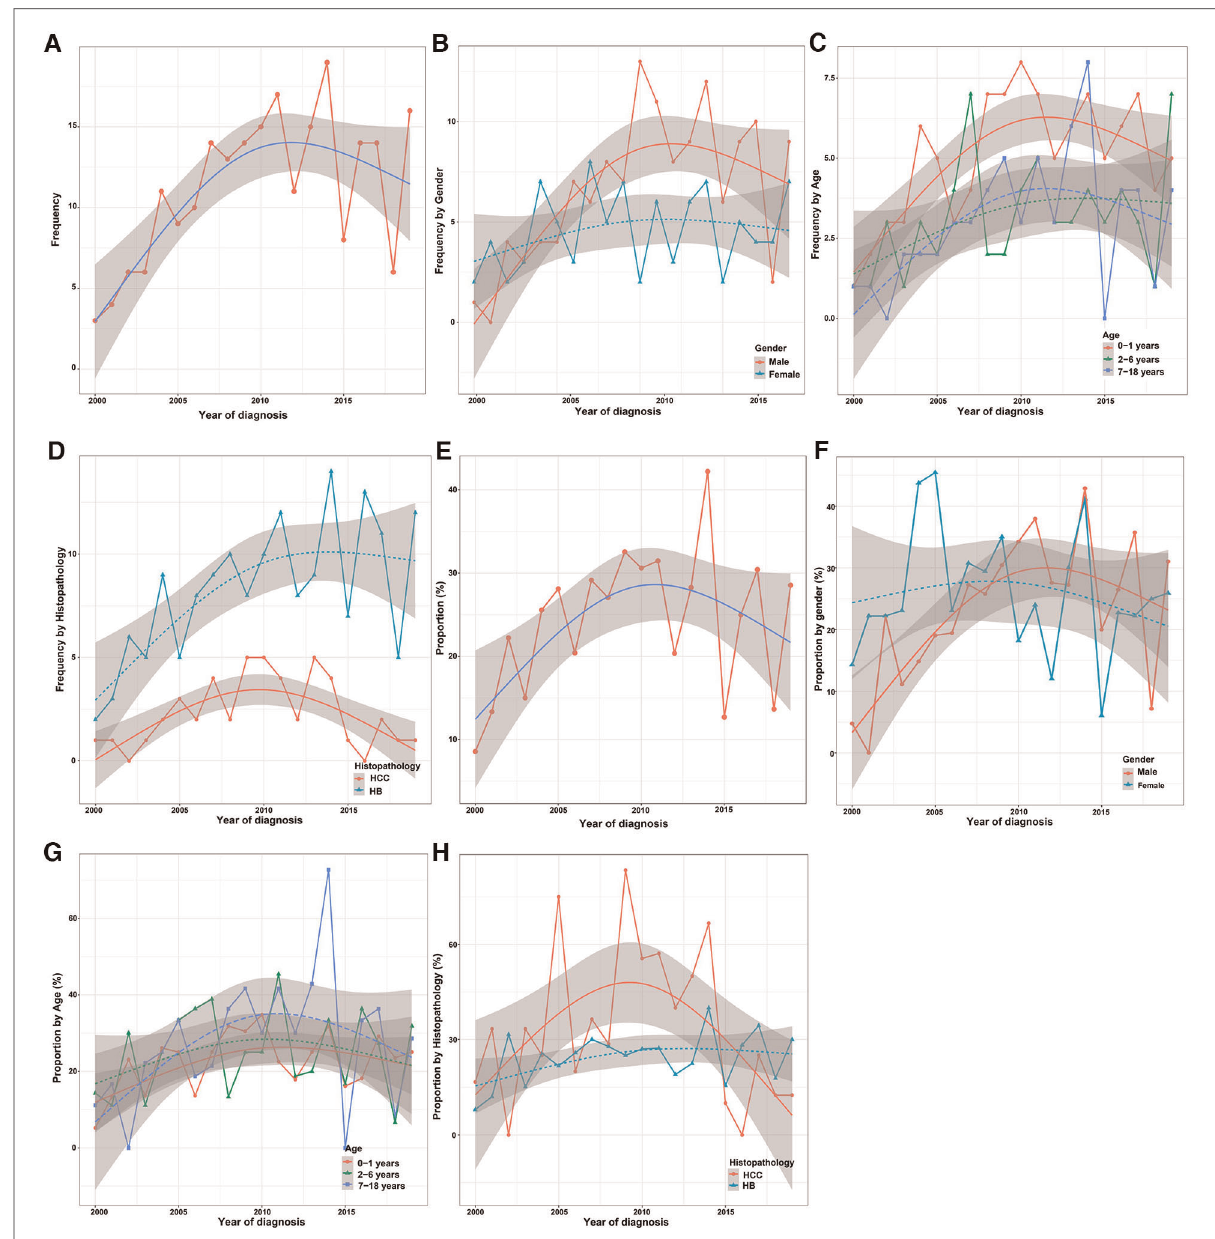
FIGURE 6 Trend in the application of LT for the treatment of children with liver cancer in different clinicopathological groups. ( A ) Trend in the application of LT for the treatment of children with liver cancer. ( B – D ) Trends in the application of LT for the treatment of children with liver cancer between different gender, age, and histopathology groups. ( E ) Proportion trend of LT for the treatment of children with liver cancer. ( F – H ) Proportion trends of LT for the treatment of children with liver cancer between different gender, age, and histopathology groups. LT, Liver